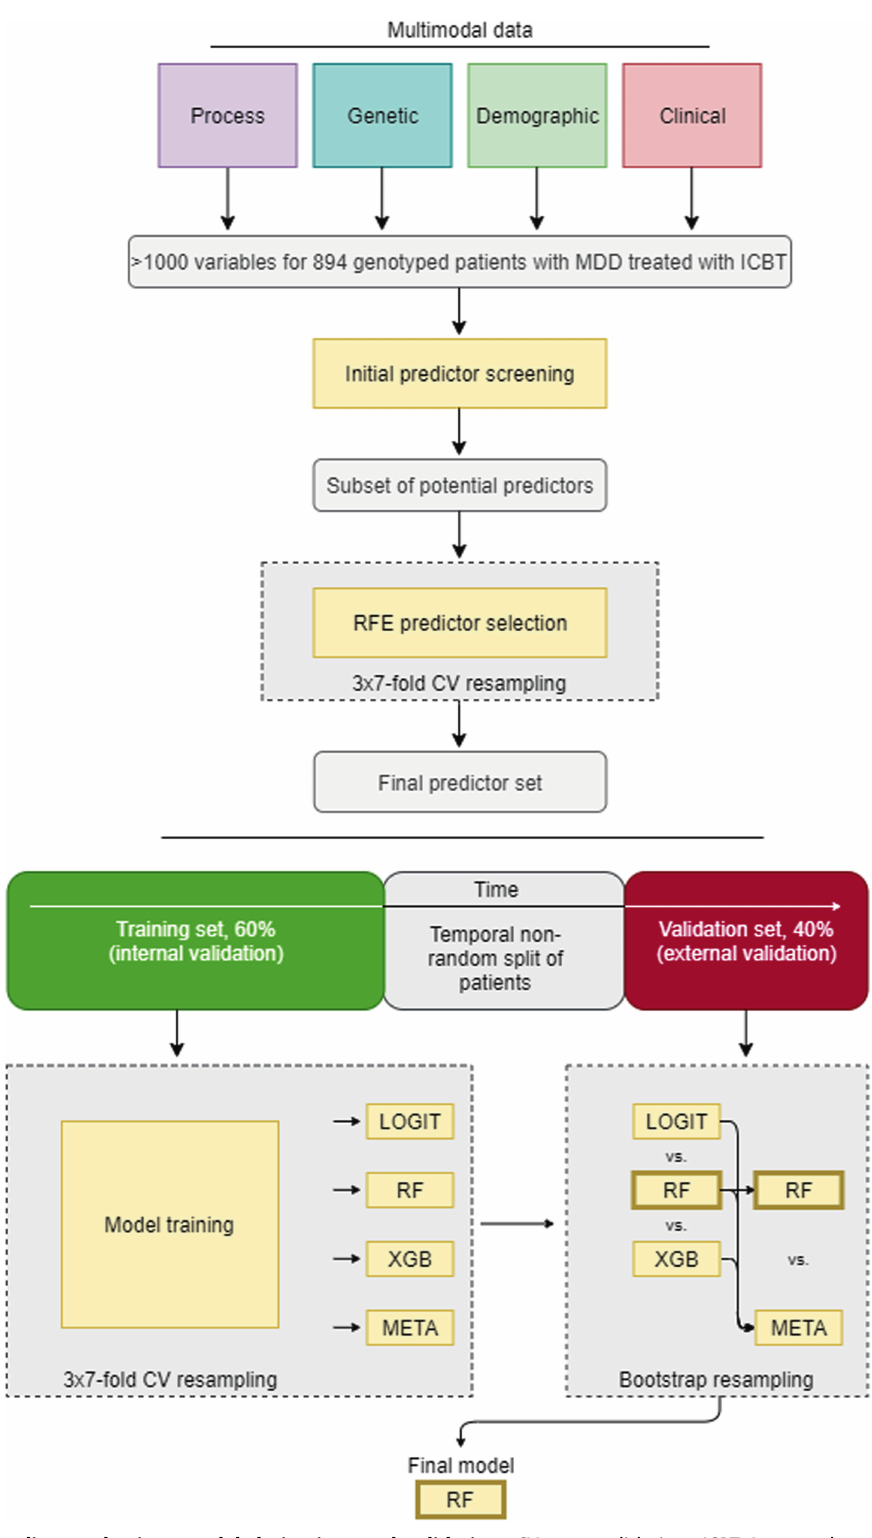
Fig. 1 Work fl ow of predictor selection, model derivation, and validation. CV cross-validation, ICBT , Internet-based Cognitive Behaviour Therapy, LOGIT binomial logistic regression, MDD Major Depressive Disorder, RF random forest, RFE recursive feature elimination, XGB eXtreme gradient boosted trees, META blended meta-ensemble model of LOGIT, RF, and